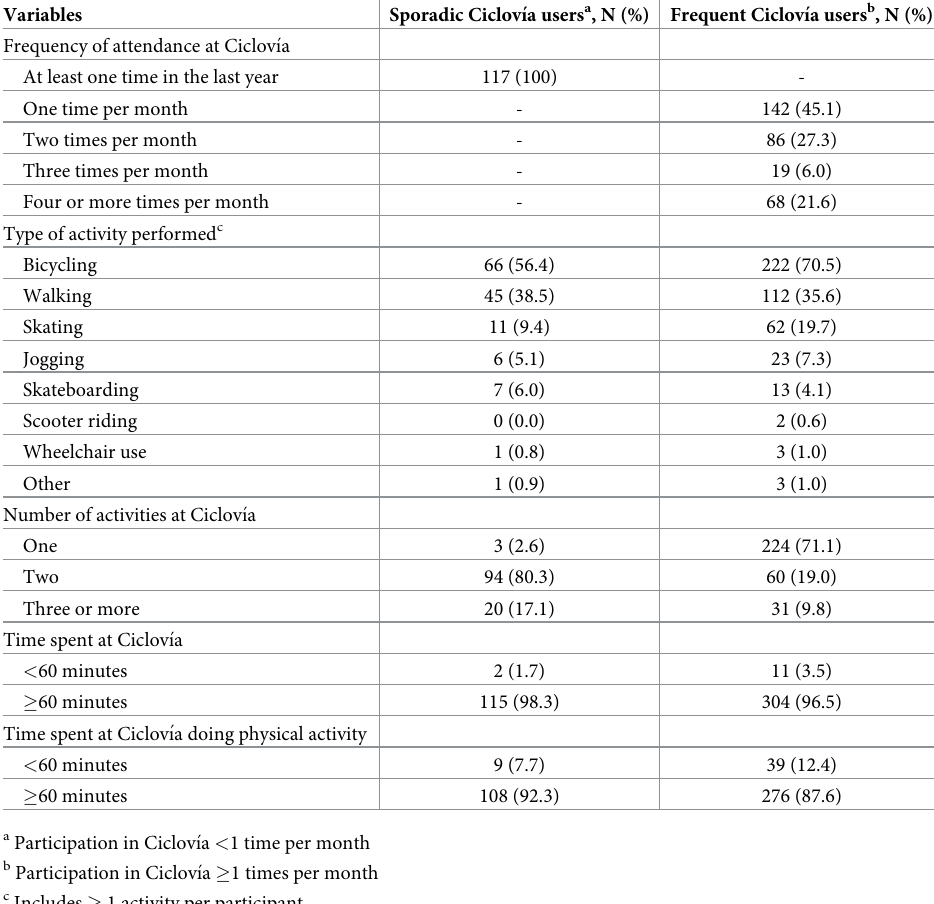
Table 2. Characteristics of the Ciclovı´a